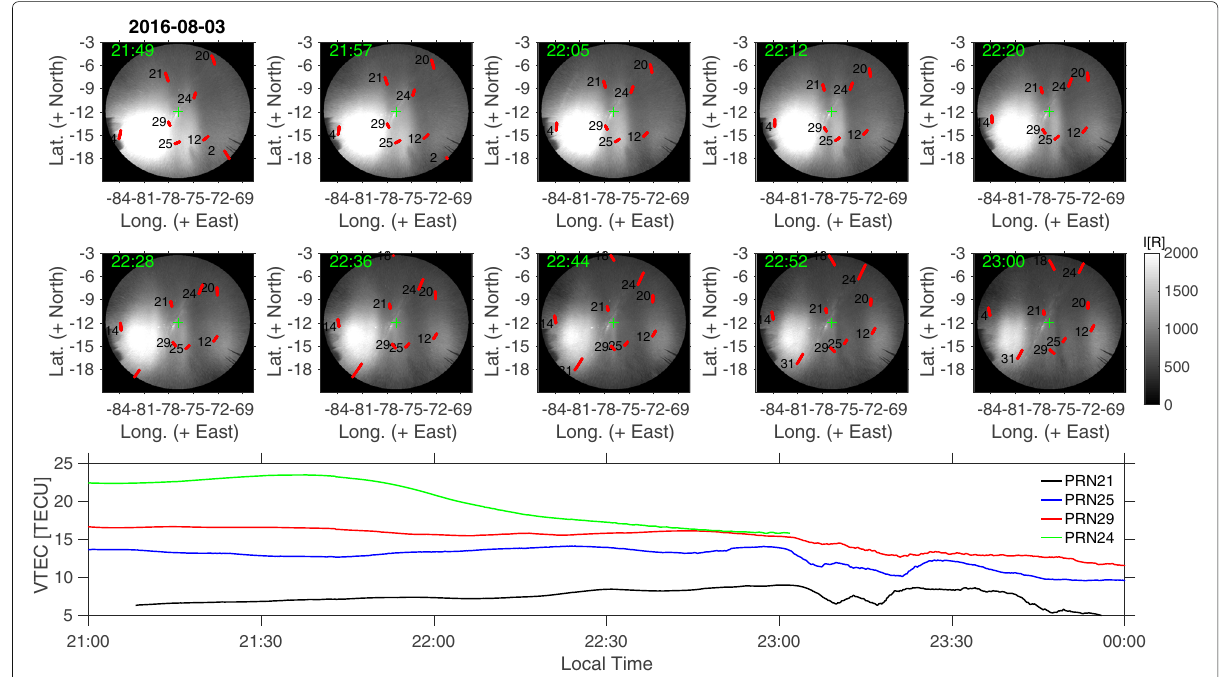
Fig. 9 Comparison of airglow perturbations and ionospheric total electron content (TEC) measurements. The top first and second rows show airglow images. The ionospheric piercing points (at 350 km altitude) for GPS satellites tracked within 8 minutes of the time the images were taken are also shown. The piercing points are shown in red with the pseudo-random noise (PRN) number indicated in each track. The bottom plot shows the vertical TEC measurements made using signals from three different satellites (PRNs 21, 25, 29, and 24). TEC depletions associated with plasma bubbles are only seen after about 23:00 LT in PRNs 21, 25, and 29. TEC data is only shown for satellites with elevation greater than